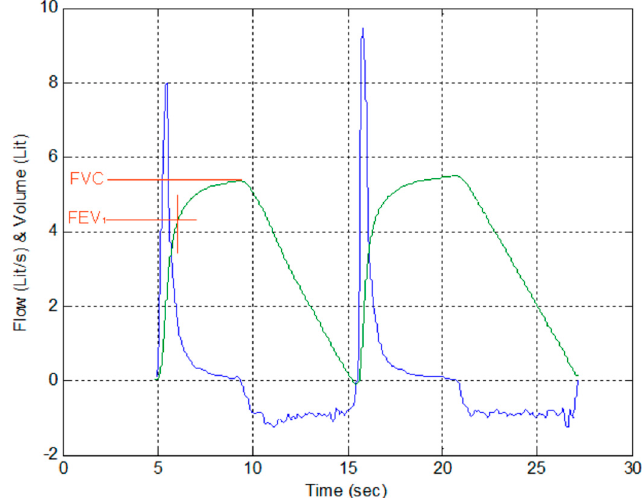
Figure 14. Measured flow rate and calculated volume for two breaths during an FEV test, with FEV1 and forced vital capacity (FVC) marked for a single breath.